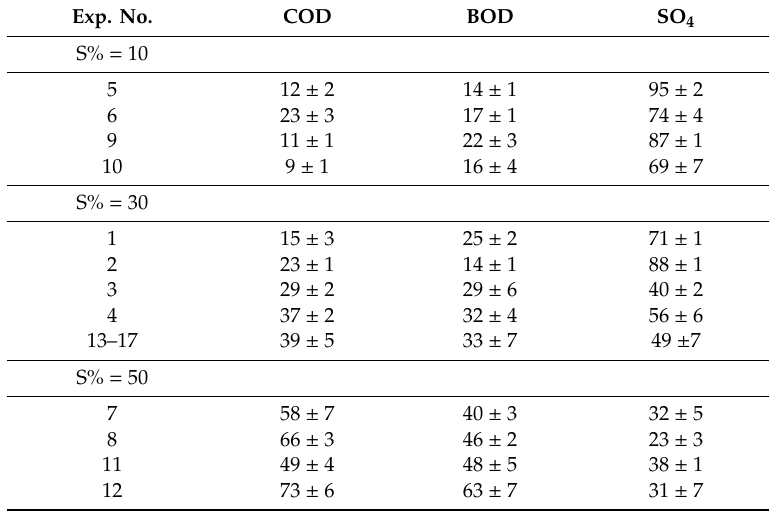
Table 9. Percentage removal of organic compounds after AD of pot ale and spent grain (5:1, by weight). Exp. No. COD BOD SO 4 S% =